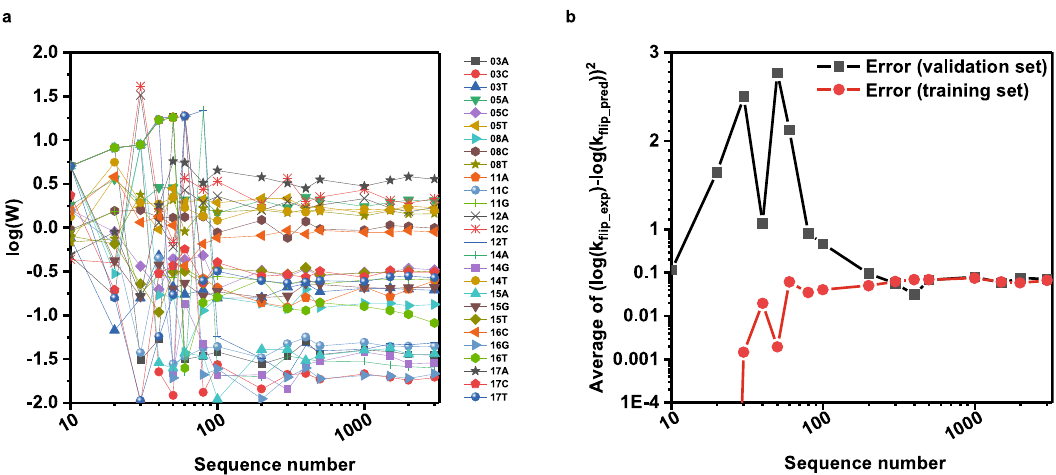
Fig. 4 Sensitivity of the model to input sequence number. a Generated weight score values, W, as a function of the size of the data set (the number on the x -axis is total data set, 70% of which are training data and 30% of which are validation data). b Difference between predicted log(k fl log(k fl ip ) of the training data set (red) and validation data set (black). Source data are provided as a Source Data fi